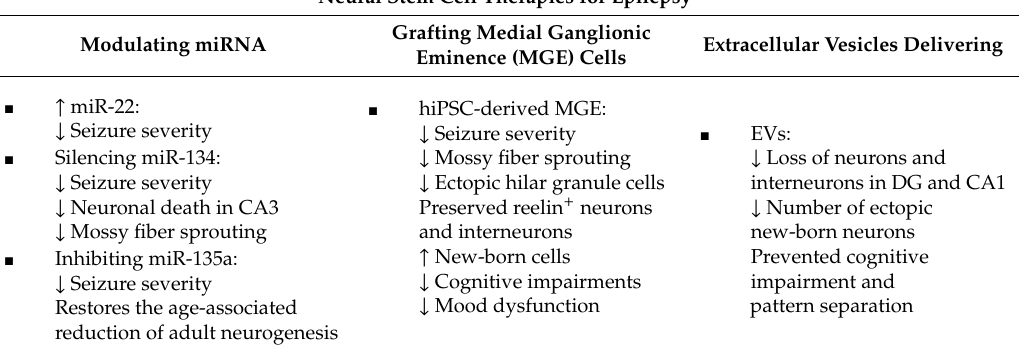
Table 1. Neural Stem Cell therapies for epilepsy. Modulating miRNA, grafting human-induced pluripotent stem cells (hiPSC)-derived medial ganglionic eminence (MGE) cells in the hippocampus, and specific delivery of extracellular vesicles derived from mesenchymal stem cells (MSC) are potential therapies to be used as a treatment for epilepsy. Neural Stem Cell Therapies for Epilepsy Grafting Medial Ganglionic Modulating miRNA Extracellular Vesicles Eminence (MGE) Cells